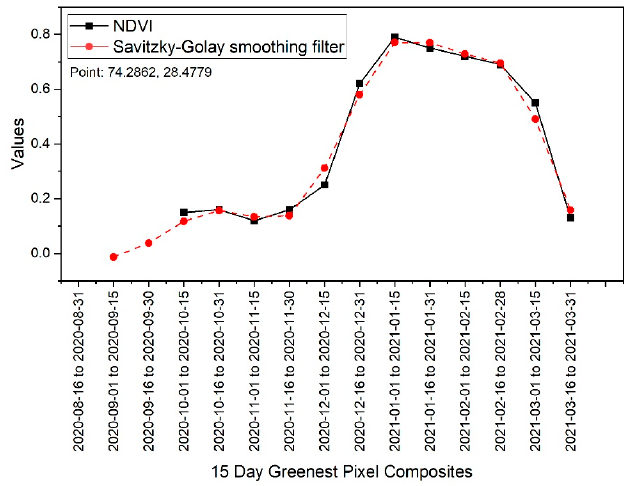
Figure 5. Rabi season time series NDVI signature.